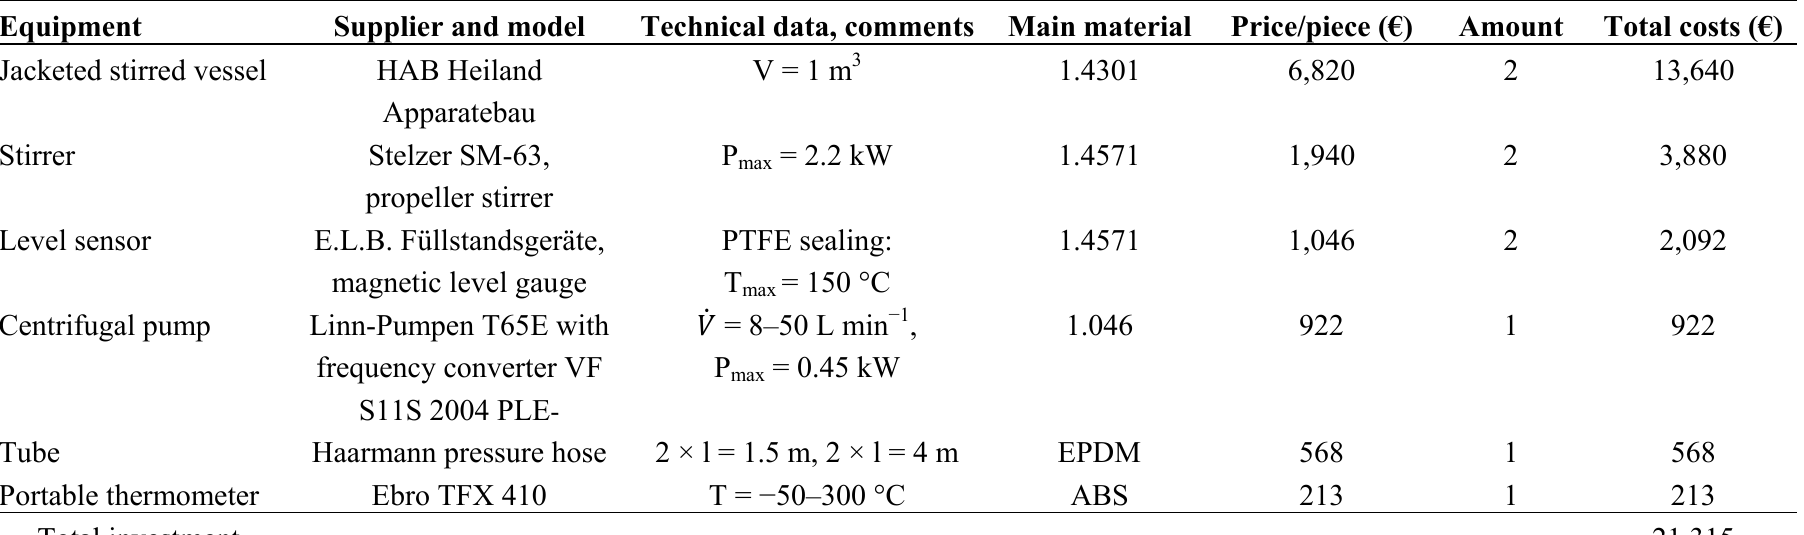
Table B-1. Equipment list and costs for the batch plant. PTFE,